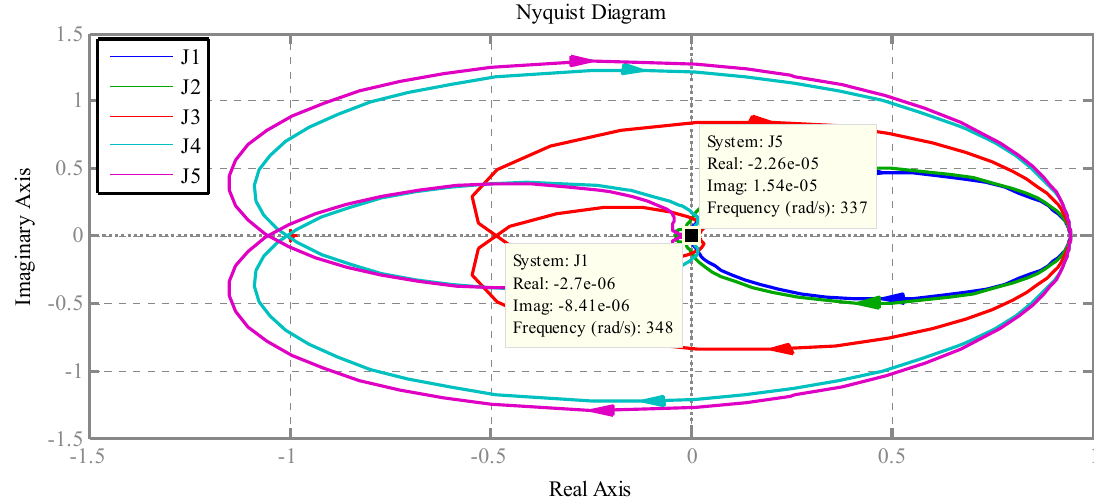
Figure 7. Various values of virtual inertia in Q / ∆ P .